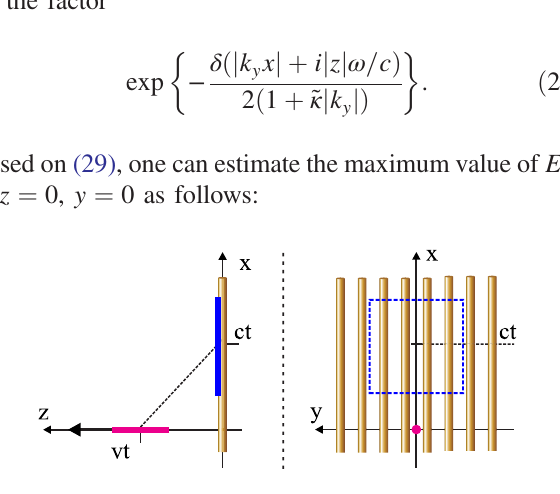
FIG. 7. Relative position of snapshots area, bunch, and wires for surface wave field distributions in Fig. 6. The area with calculated distributions is shown as a solid blue vertical line on the left projection and as a square with a dashed blue border on the right projection. The bold arrow shows the direction of the bunch